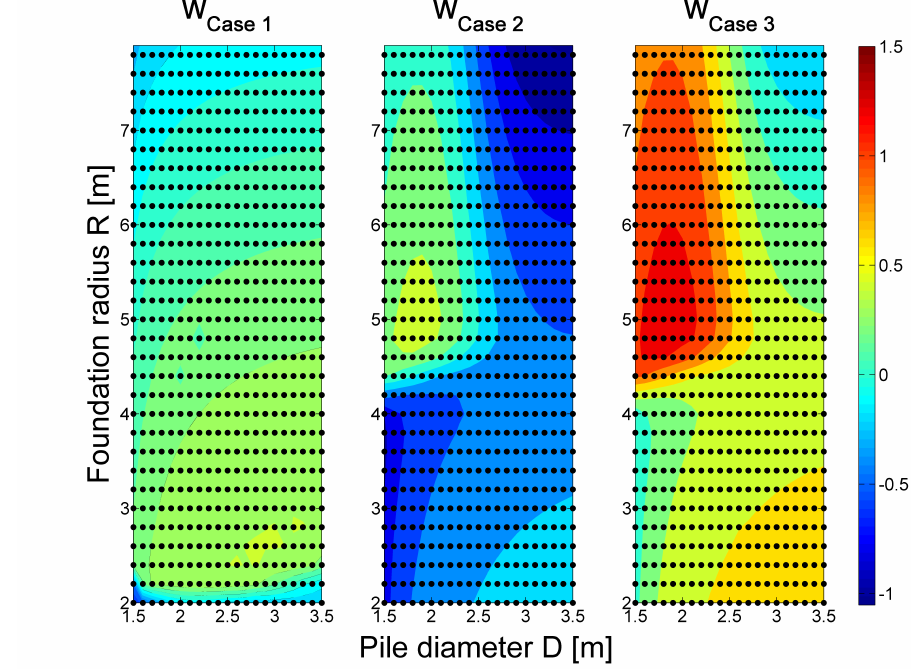
Figure 5. Profitability W dependent on the pile diameter D and foundation radius R . W : profitability prototype level; W Case 1 profitability commercial